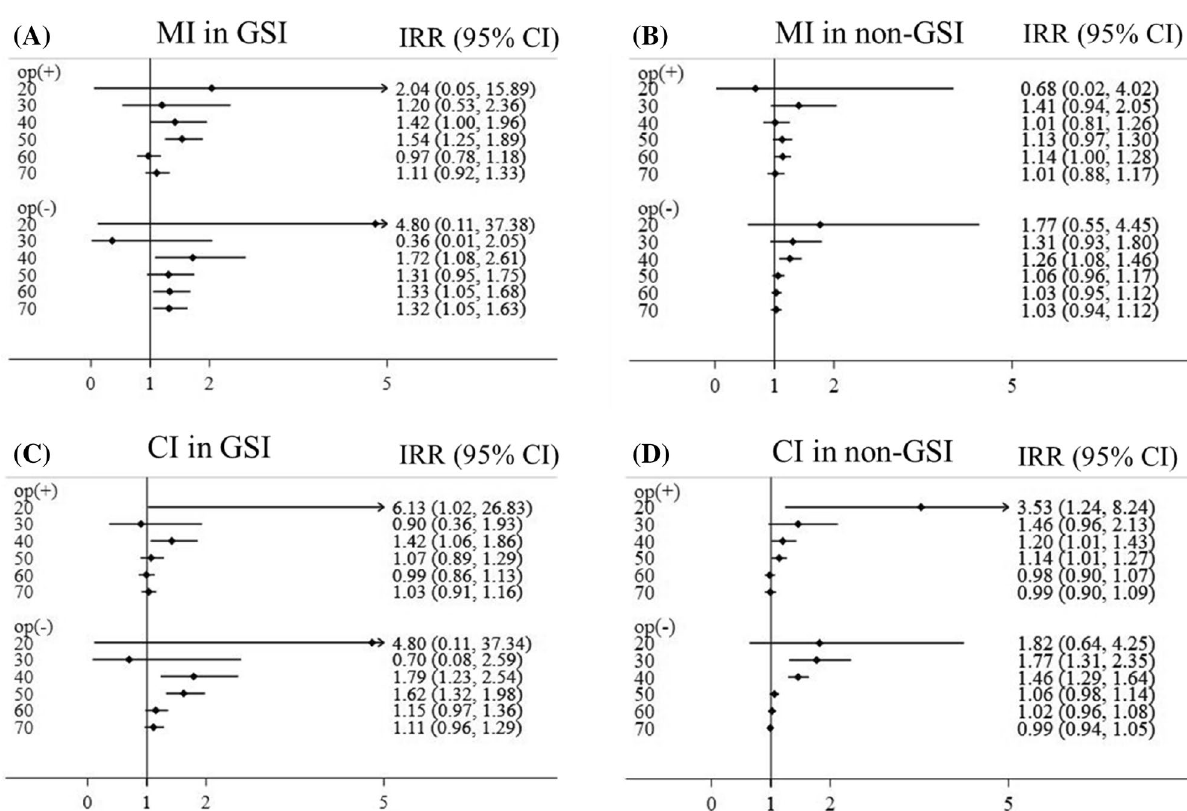
Figure 4. Incidence rate ratios of myocardial infarction (MI) and cerebral infarction (CI) according to gallstone-related infection (GSI) and cholecystectomy in age groups. ( A , B ) myocardial infarction, ( A ) GSI, ( B ) non-GSI. ( C , D )cerebral infarction, ( C ) GSI, ( D ) non-GSI. op,